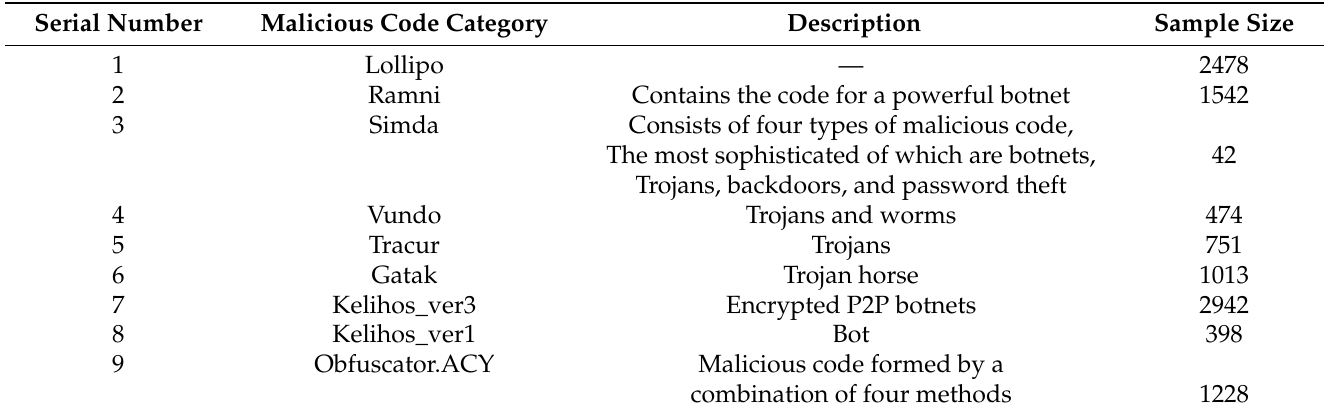
Table 4. The types of malicious